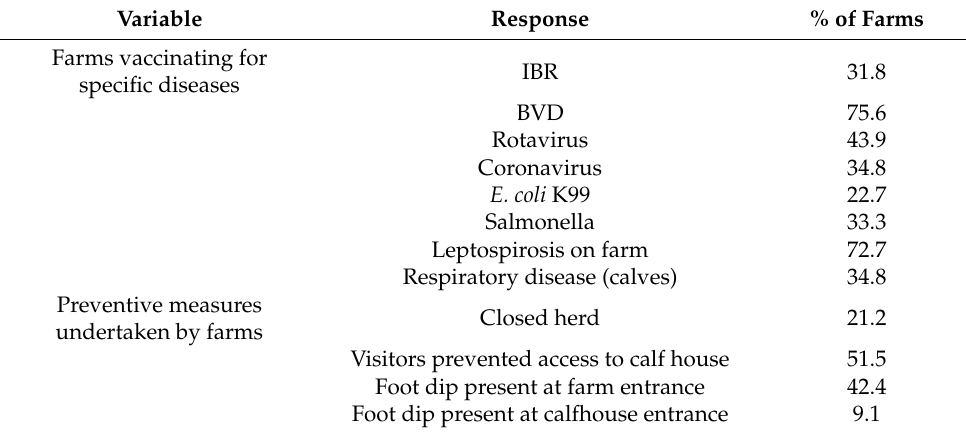
Table 7. Farm health and disease